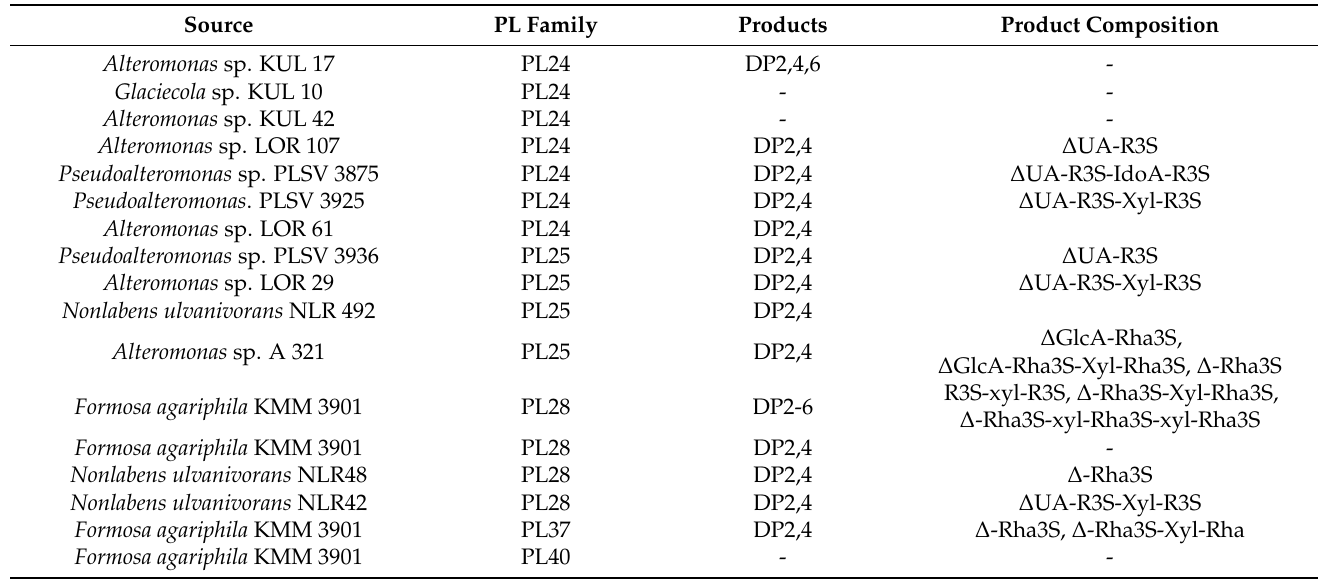
Table 1. List of previously isolated ulvan-degrading bacteria and polysaccharide lyase enzyme family or degradation products from